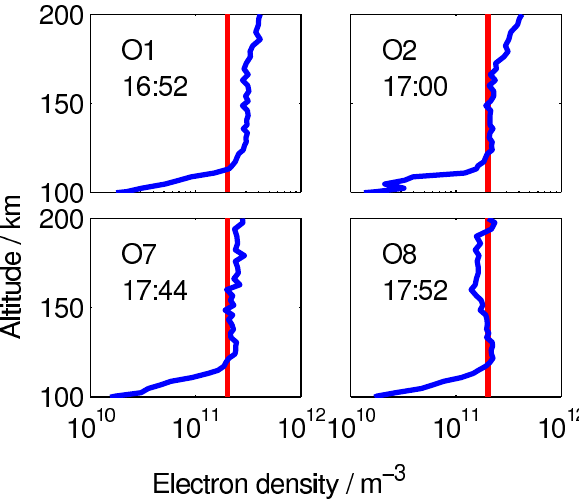
Fig. 4. Electron density profiles (1min integration) measured with the radar close to the heating cycles discussed. The time inlay, in UT, indicates the corresponding heating cycle and the red vertical line is the critical density for the heater wave.